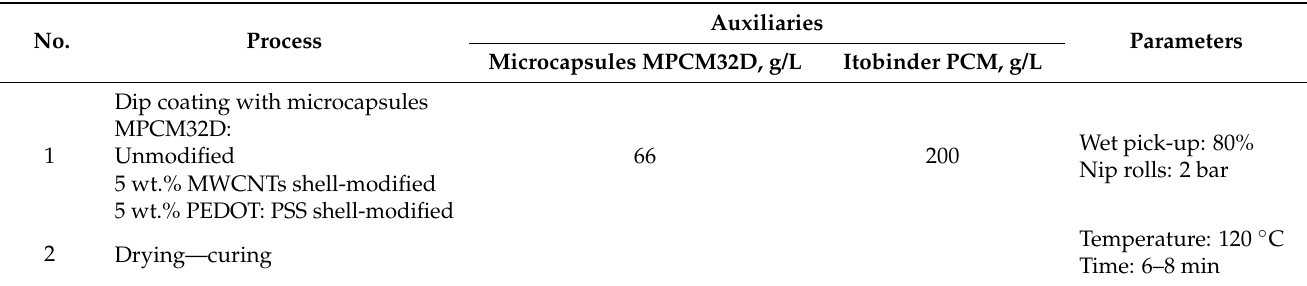
Table 2. Parameters of dip coating and drying-curing